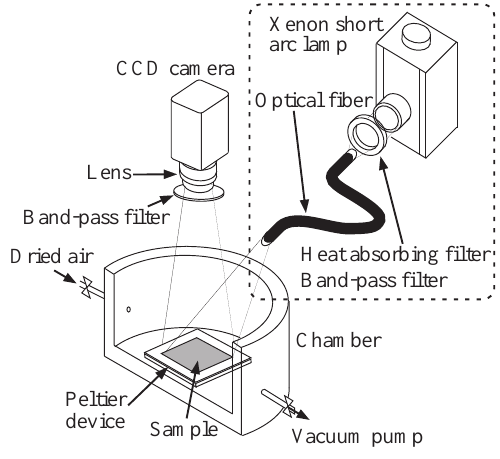
Figure 2. Schematic image of experimental setup. The illumination light source inside the dashed box is only used for the photoluminescence